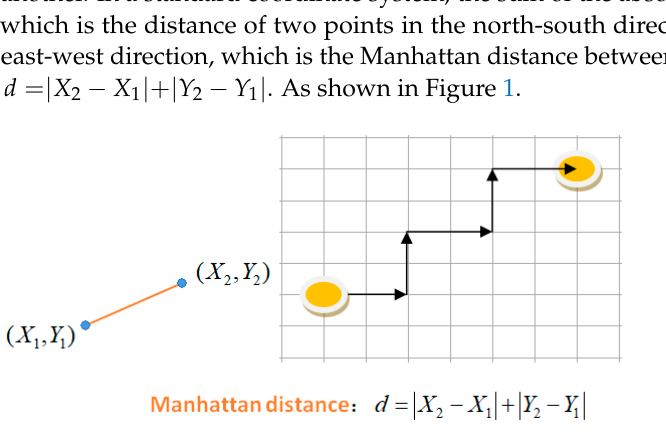
Figure 1. Manhattan distance.